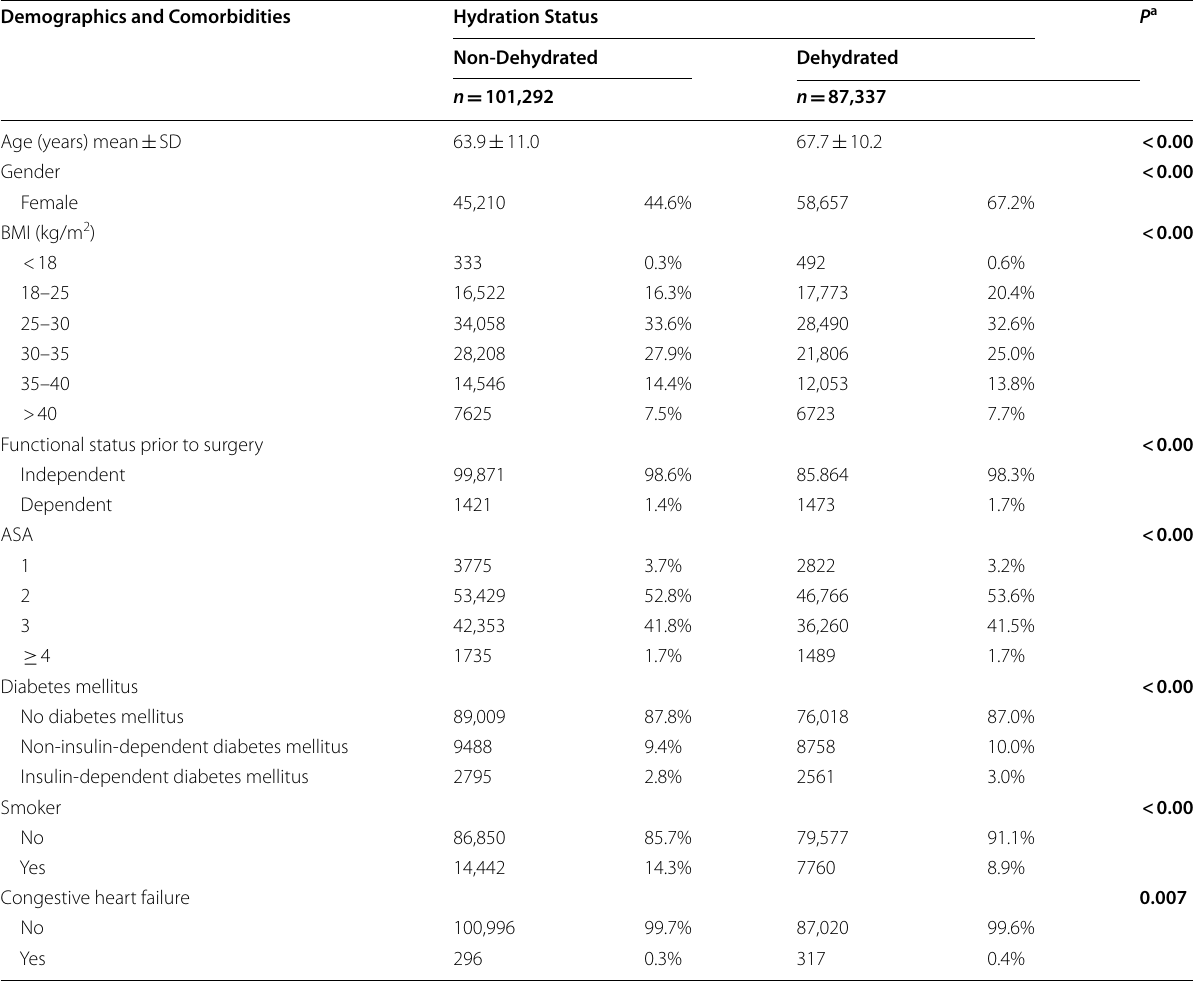
Bold fonts indicate statistical significance a Statistical significance set at P <